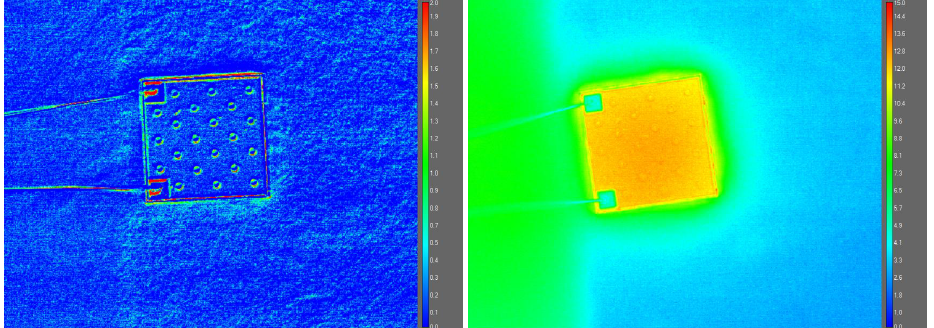
Figure 7. Spatially resolved differential temperature distribution across the surface of a single LED from a 2 × 2 matrix with 125 mA into the LED in pulsed mode ( left ) and DC ( right ). The LED dimension is 930 µ m × 930 µ m. The colorbar unit is ◦